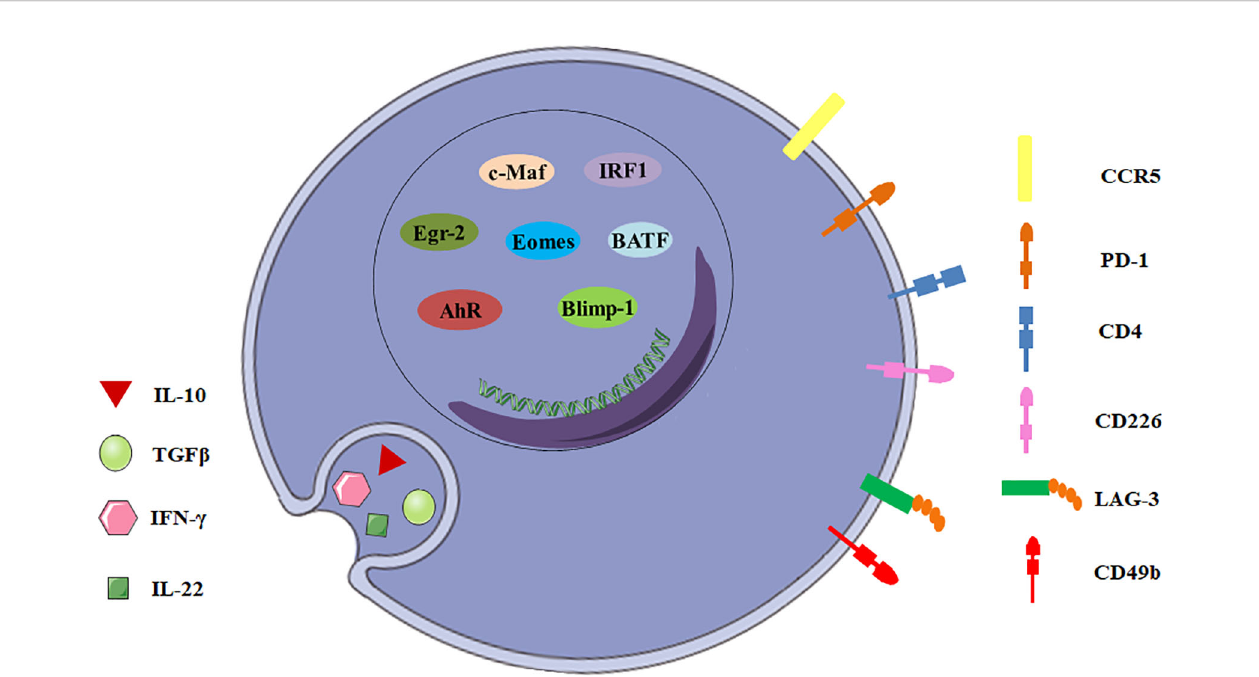
FIGURE 1 | General characteristics of Tr1 cells. The biomarkers for Tr1 cells include surface molecules, secreted cytokines and transcription